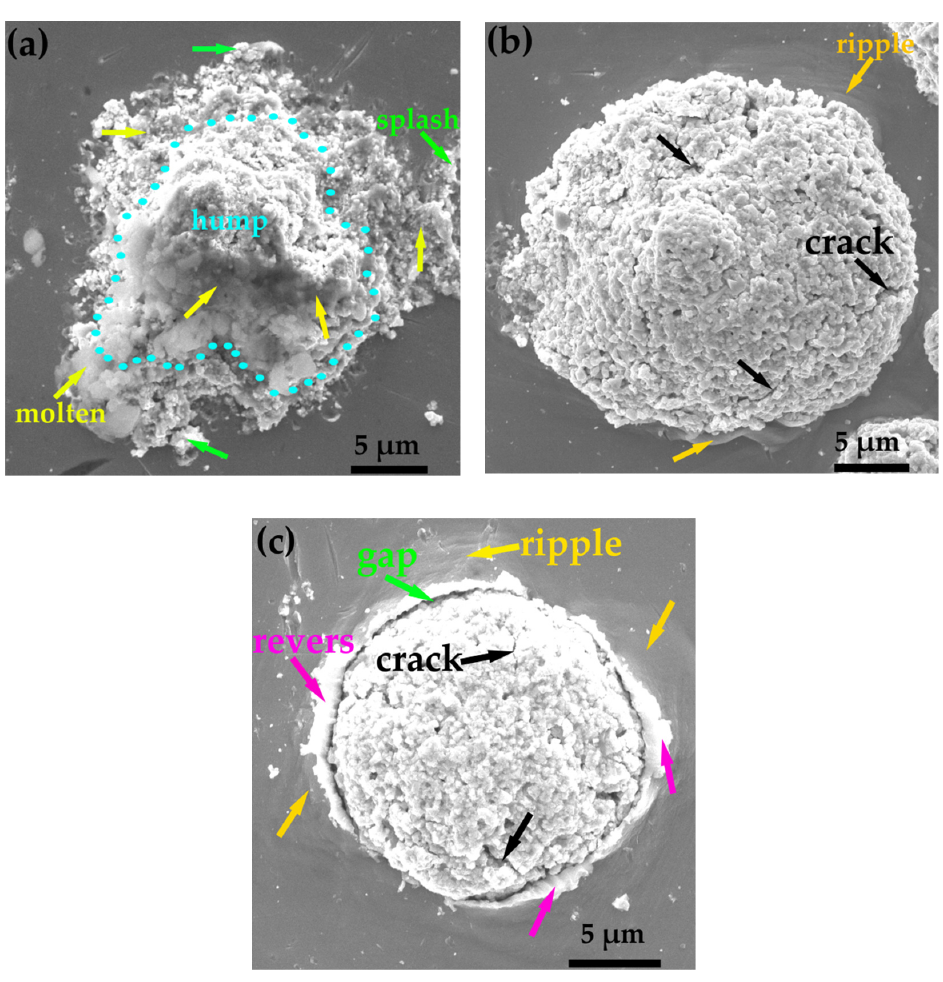
Figure 7. Surface morphologies of WC-17Co splats deposited by various spraying methods ( a ) HVOF, ( b ) WS, ( c ) CS.